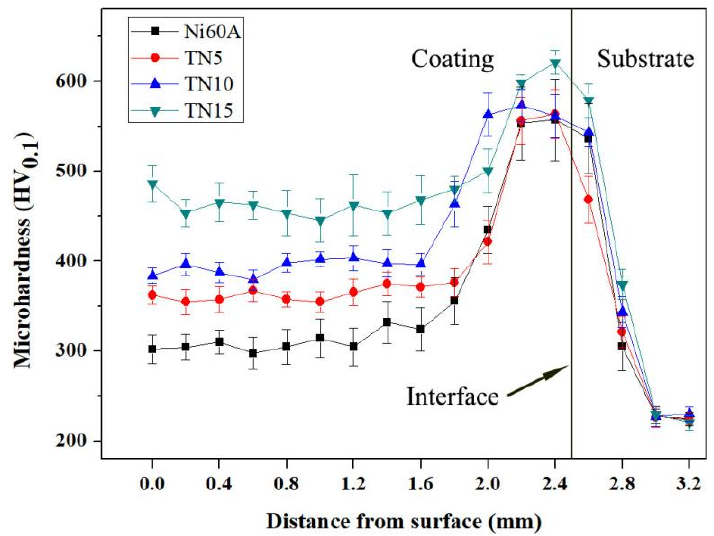
Figure 8. Microhardness profile along the depth direction of the coatings.